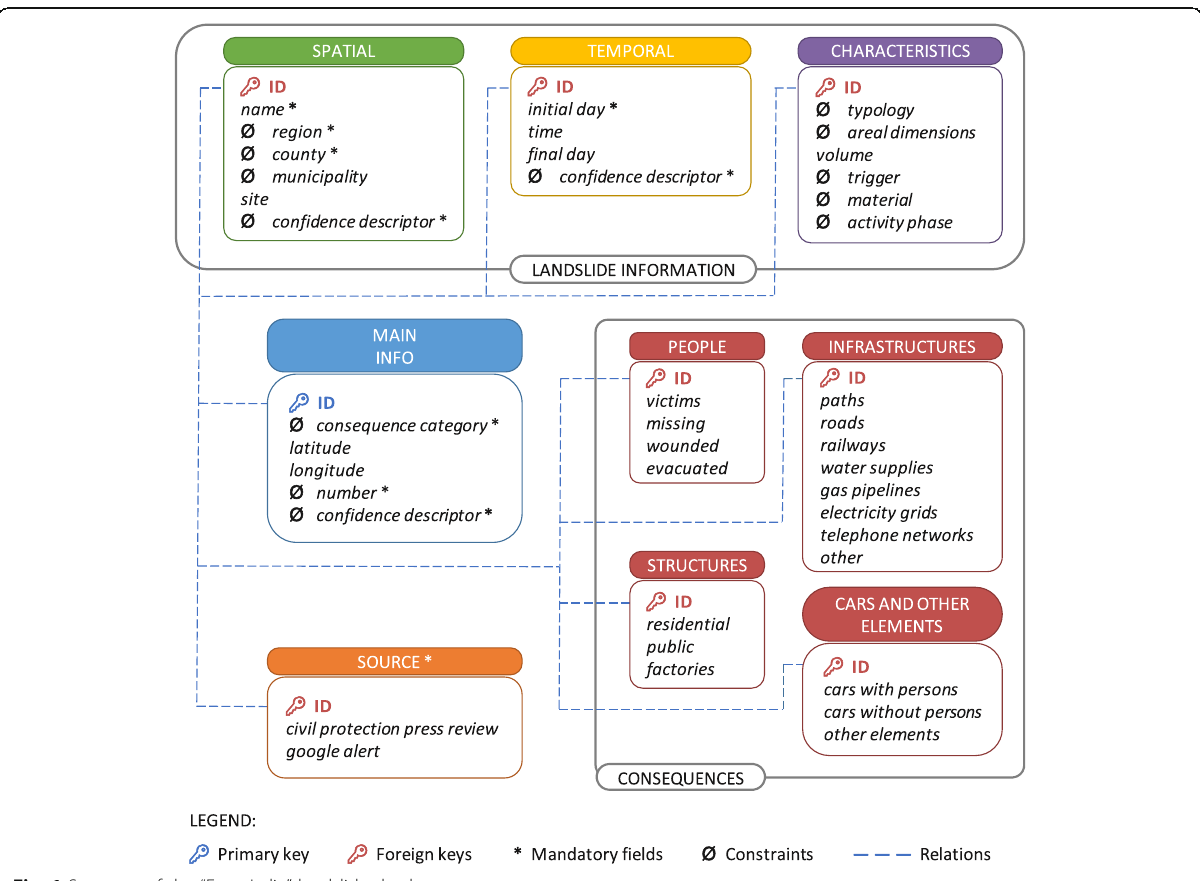
Fig. 1 Structure of the “ FraneItalia ” landslide